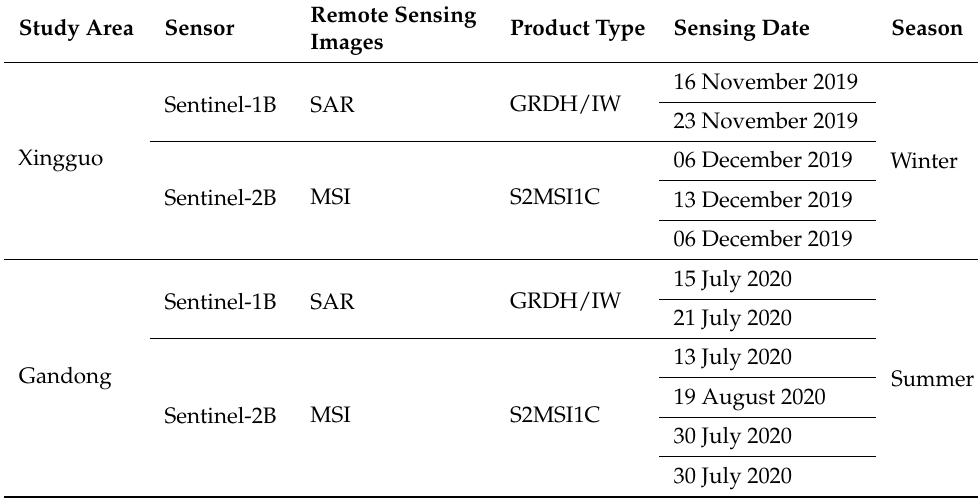
Table 1. The Sentinel-1 and 2 imagery utilized in this